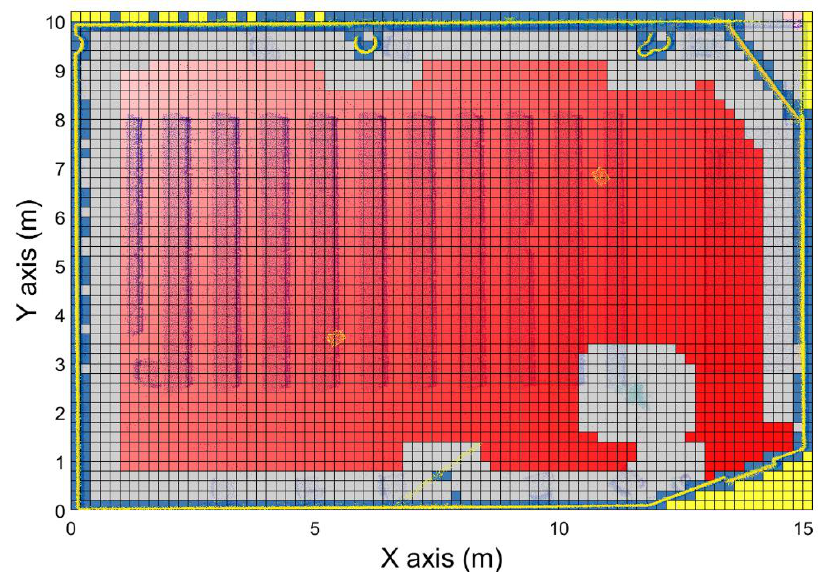
Figure 11. Horizontal plane of voxels of the navigation map (red: Navigable voxels, the transpar- ency shows the value of each voxel; grey: Security offset; yellow: Exterior voxel; dark blue: Occupied voxel).